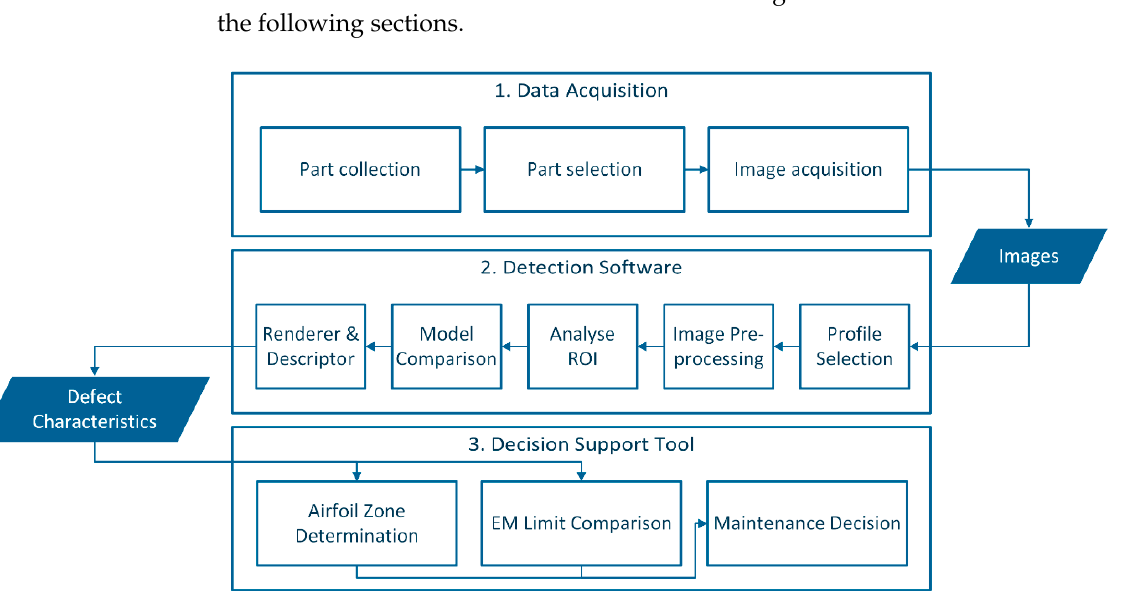
Figure 4. Overview of research approach.